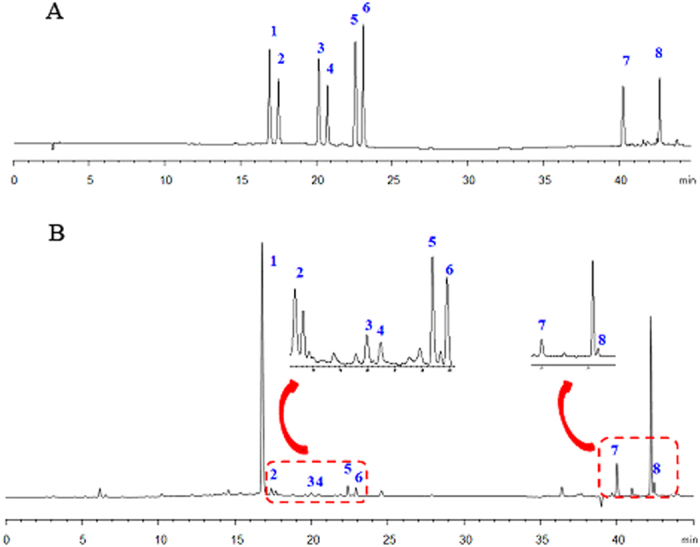
Chromatograms for standard substances (A) and QiBaoMeiRan formula (B) 1. Stilbeneglucoside, 2. Ferulic acid, 3. β-Ecdysone, 4. Psoralen, 5. Quercetin, 6. Isopsoralen, 7. Emodin, 8.Physcion.